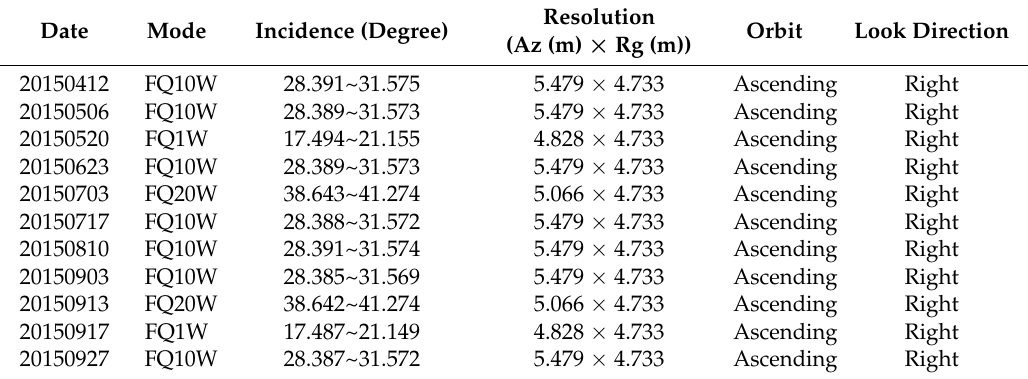
Table 1. The acquired RADARSAT ‐ 2 polarimetric SAR data description.